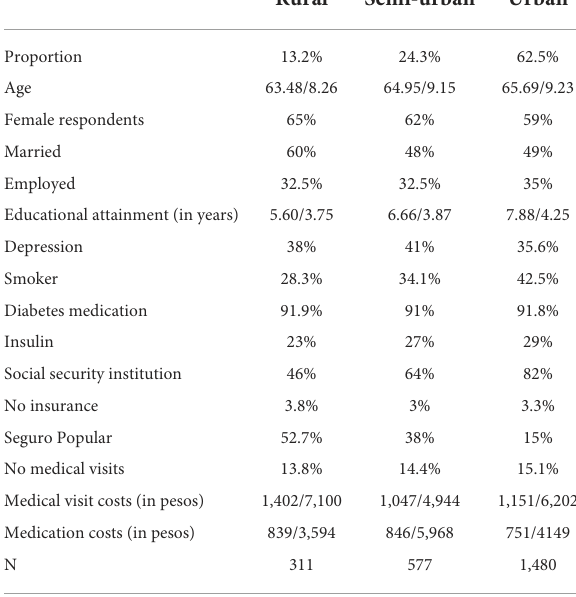
TABLE 1 Summary Demographics (% or mean/SD), adults aged 65 Years or older who have been diagnosed with diabetes ( n = 2,368), 2018 Mexican health and aging